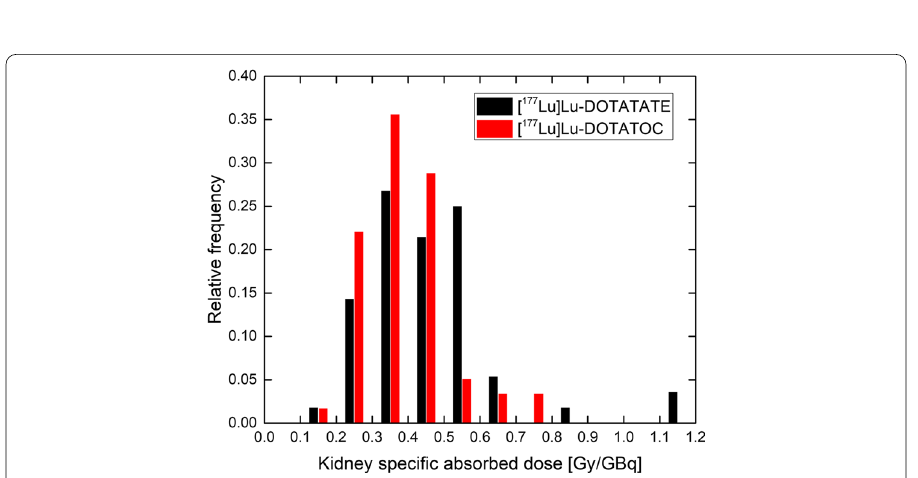
Fig. 8 Relative frequency of specific absorbed doses (average over left and right kidneys) for [ 177 Lu] Lu-DOTATATE and [ 177 Lu]Lu-DOTATOC 3-SPECT